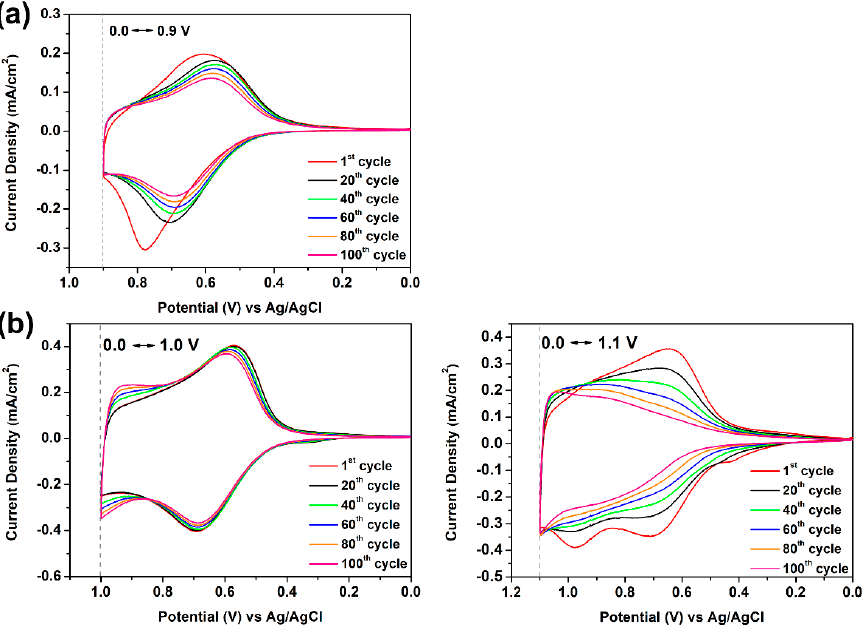
NClO /MeCN at 4 4